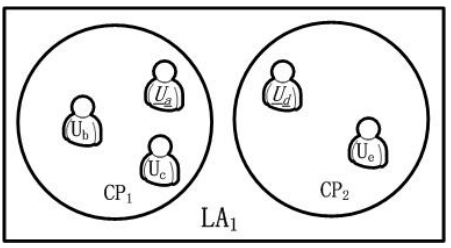
Figure 8. Scenario